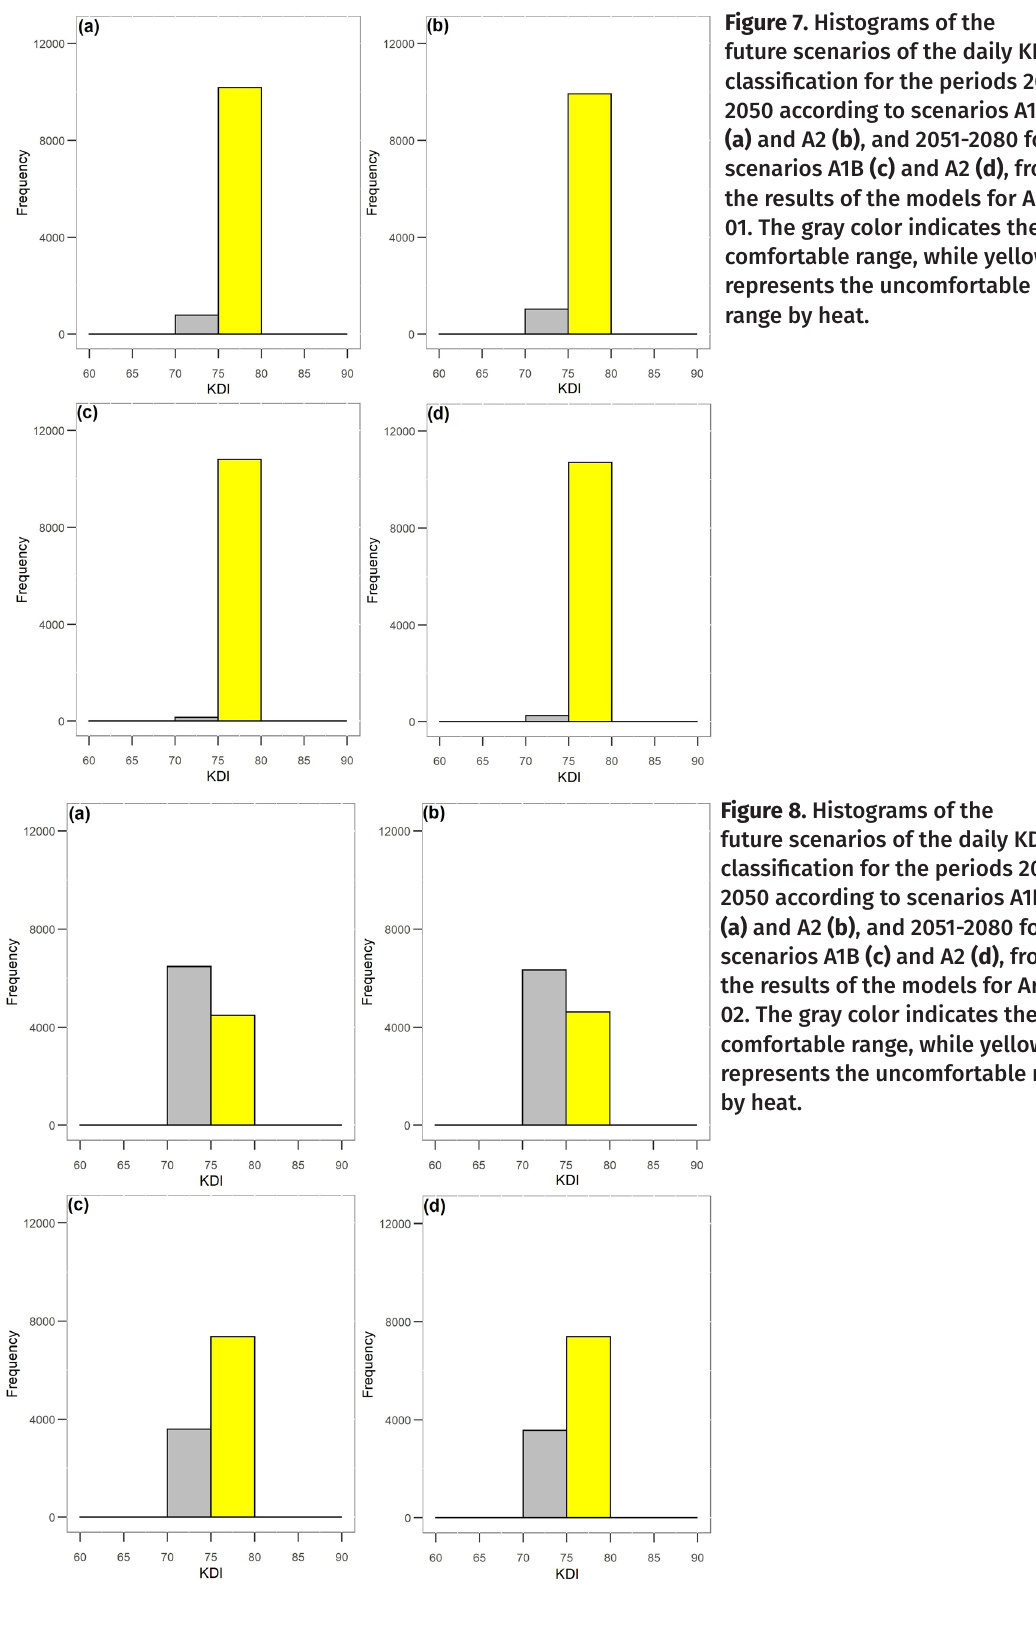
Figure 7. Histograms of the future scenarios of the daily KDI classification for the periods 2021- 2050 according to scenarios A1B (a) and A2 (b) , and 2051-2080 for scenarios A1B (c) and A2 (d) , from the results of the models for Area 01. The gray color indicates the comfortable range, while yellow represents the uncomfortable range by heat.